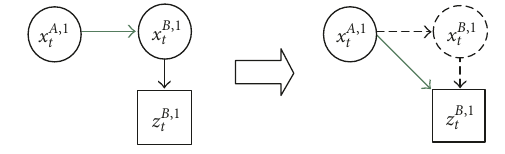
Figure 2: Equivalent simplification of camera collaboration link. The link causality from grandparent to parent then to grandson node is replaced by a direct link from grandparent to grandson node.